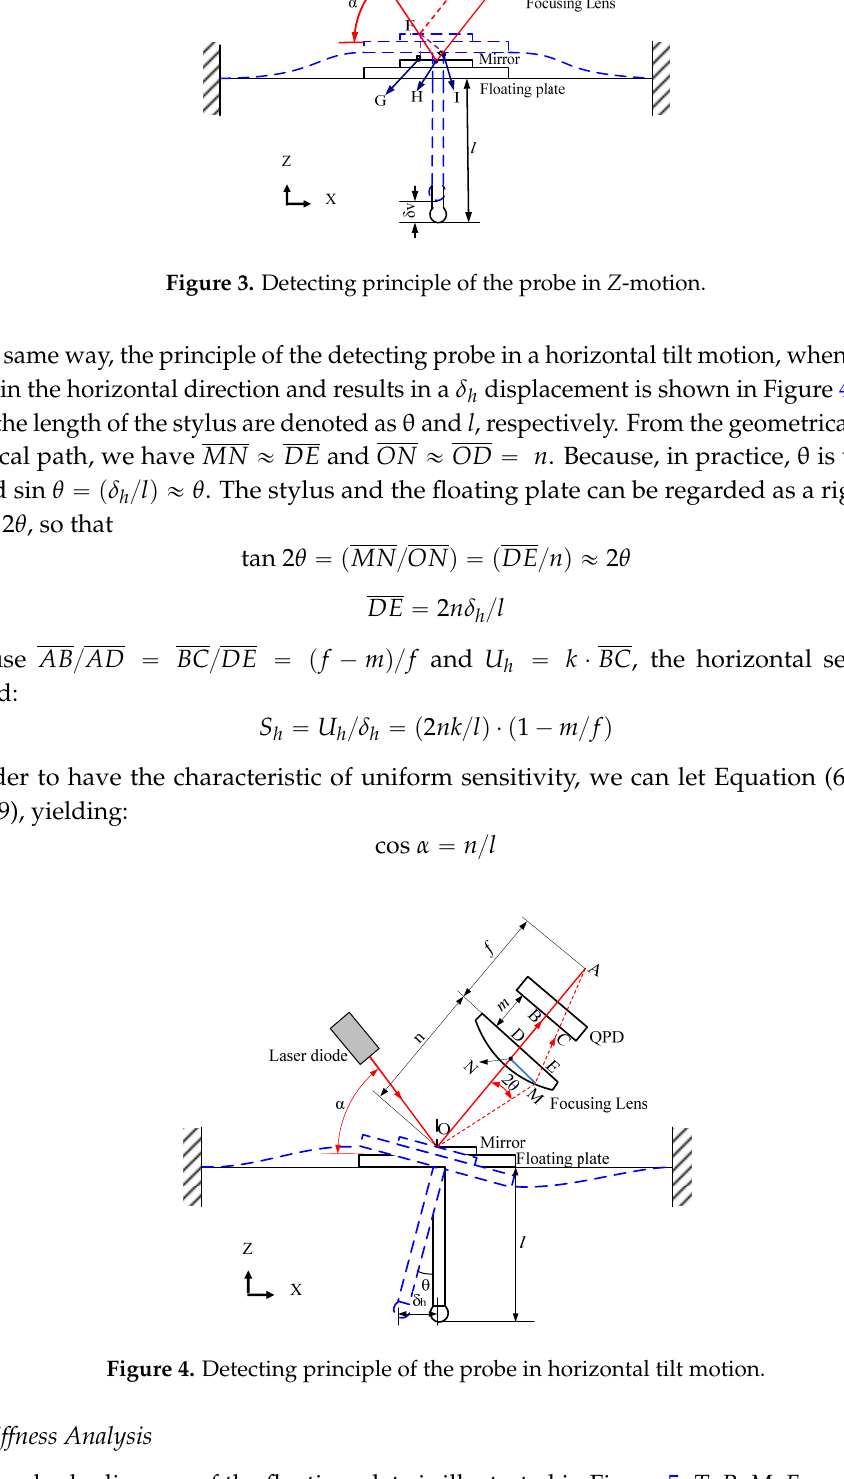
Figure 3. Detecting principle of the probe in Z ‐ motion.